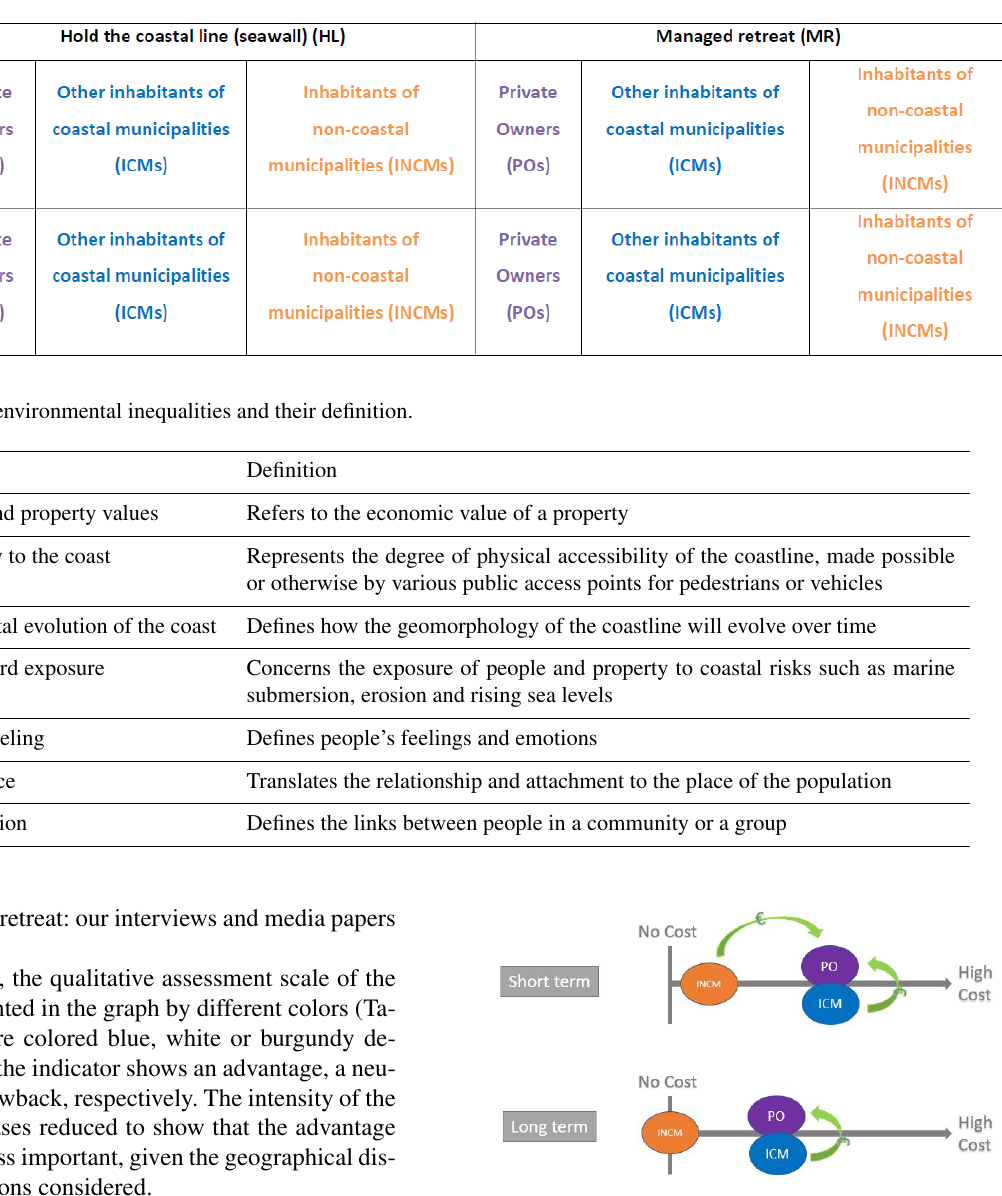
Figure 2. Evolution of cost for the “hold the coastal line” strategy.